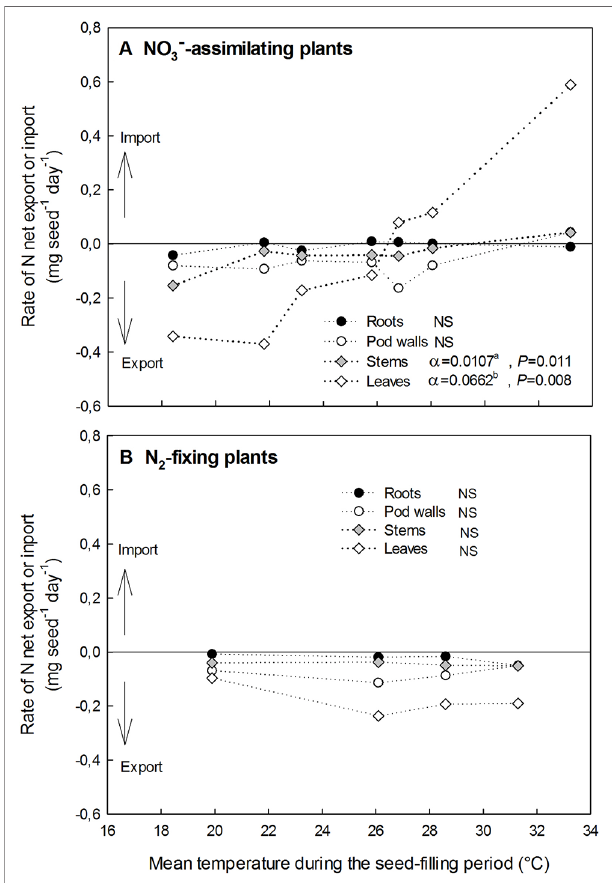
FIGURE 5 | Impacts of the temperature increase on the rate of net N export or import in vegetative organs (roots, pod walls, stems, and leaves) during the seed- − -assimilating plants (A) and N fi xing plants (B) . a fi lling period for NO 3 2 - represents the linear regressions correlation coef fi cient of the net N export (or import) in each vegetative organ v. temperature. NS, not signi fi cantly different from 0 ( P < 0.05).Values with different letters are statistically different at P =